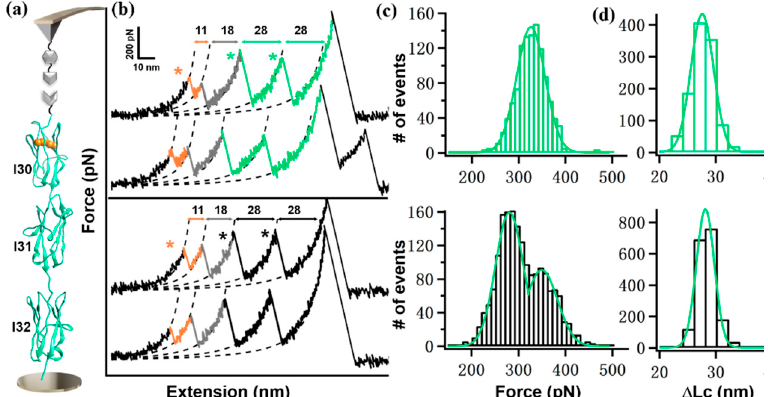
Figure 4. ( a ) Scheme of AFM-SMFS setup to measure I(30-32) domains. ( b ) Representative force- extension curves from polyprotein with linkers (top, colored in green) and without linker (bottom, in black). ( c , d ) Histograms of their corresponding unfolding force ( c ) and Δ Lc ( d ) are shown. The star indicates the unfolding event/peak.